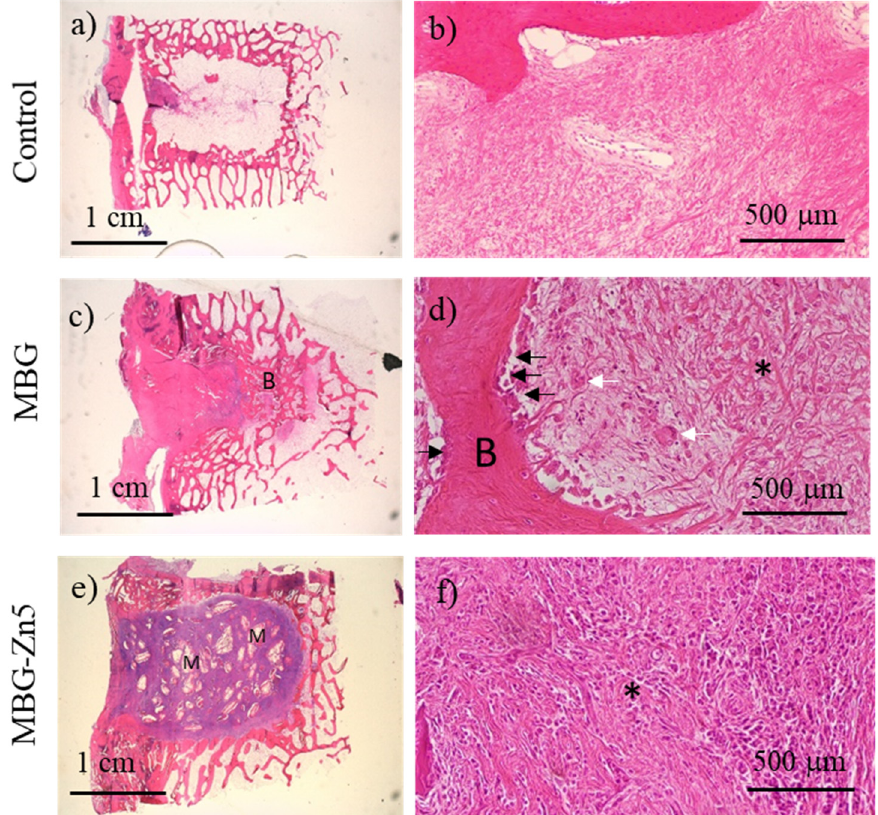
Figure 10. Histological images 12 weeks after implantation of control (a and b), MBG (c and d), and MBG-Zn5 (e and f) (left column: magnification ×3; right column: magnification ×20). (B) Bone. (Black arrows) osteoblasts. (White arrows) osteoclasts. (M) Implanted material. (*) Inflammatory component.